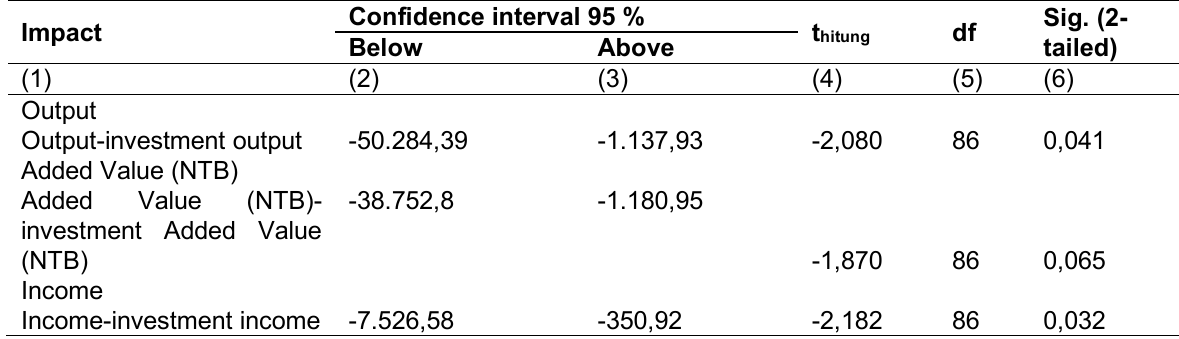
Table 10: Calculation Results of average output difference, Added Value (NTB), and income before